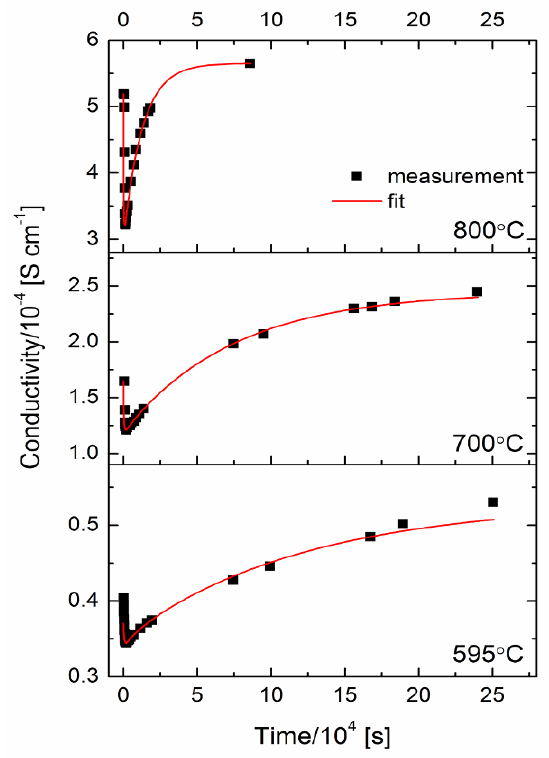
Figure 7. Electrical conductivity of SrZr